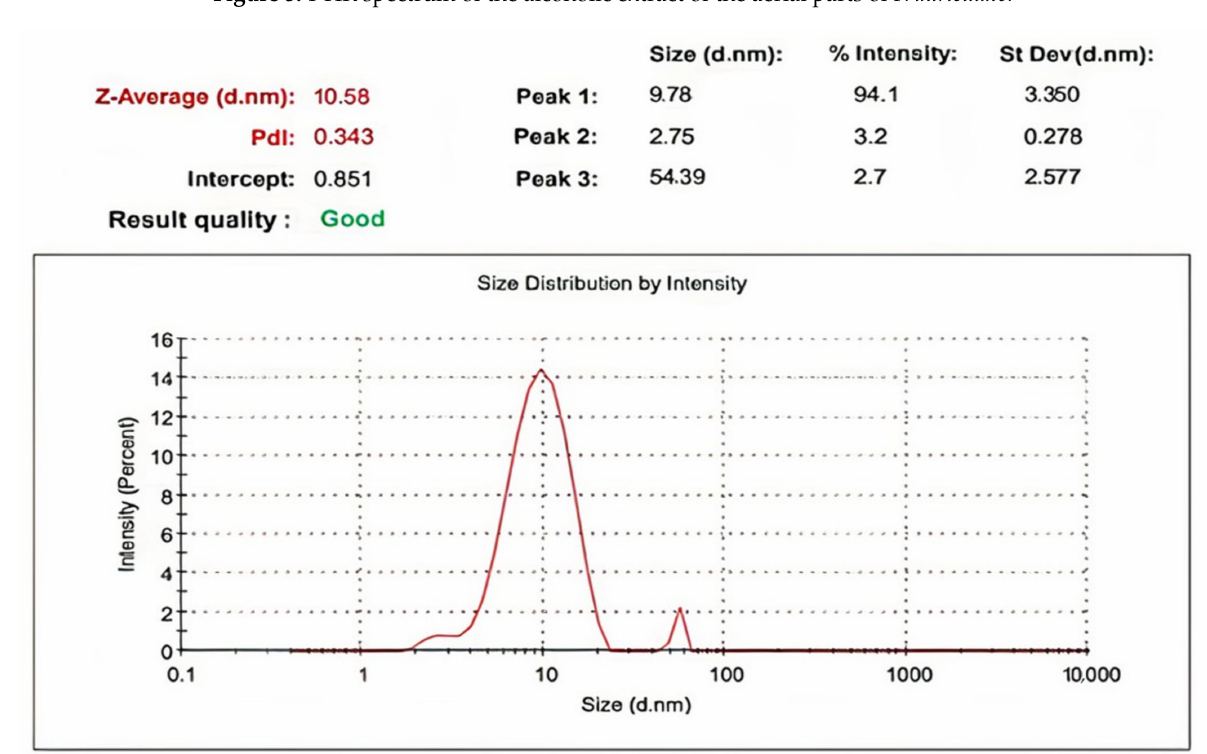
Figure 6. Zeta size of biosynthesized zinc oxide